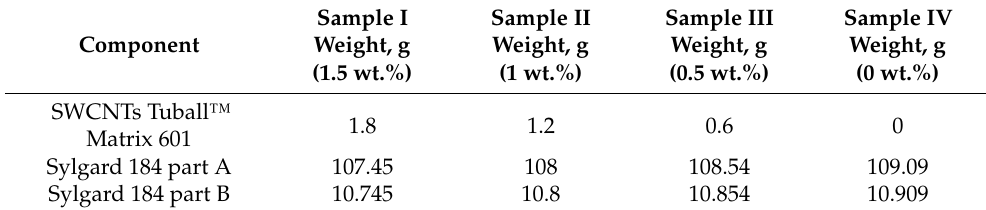
Table 1. Composite material preparation.